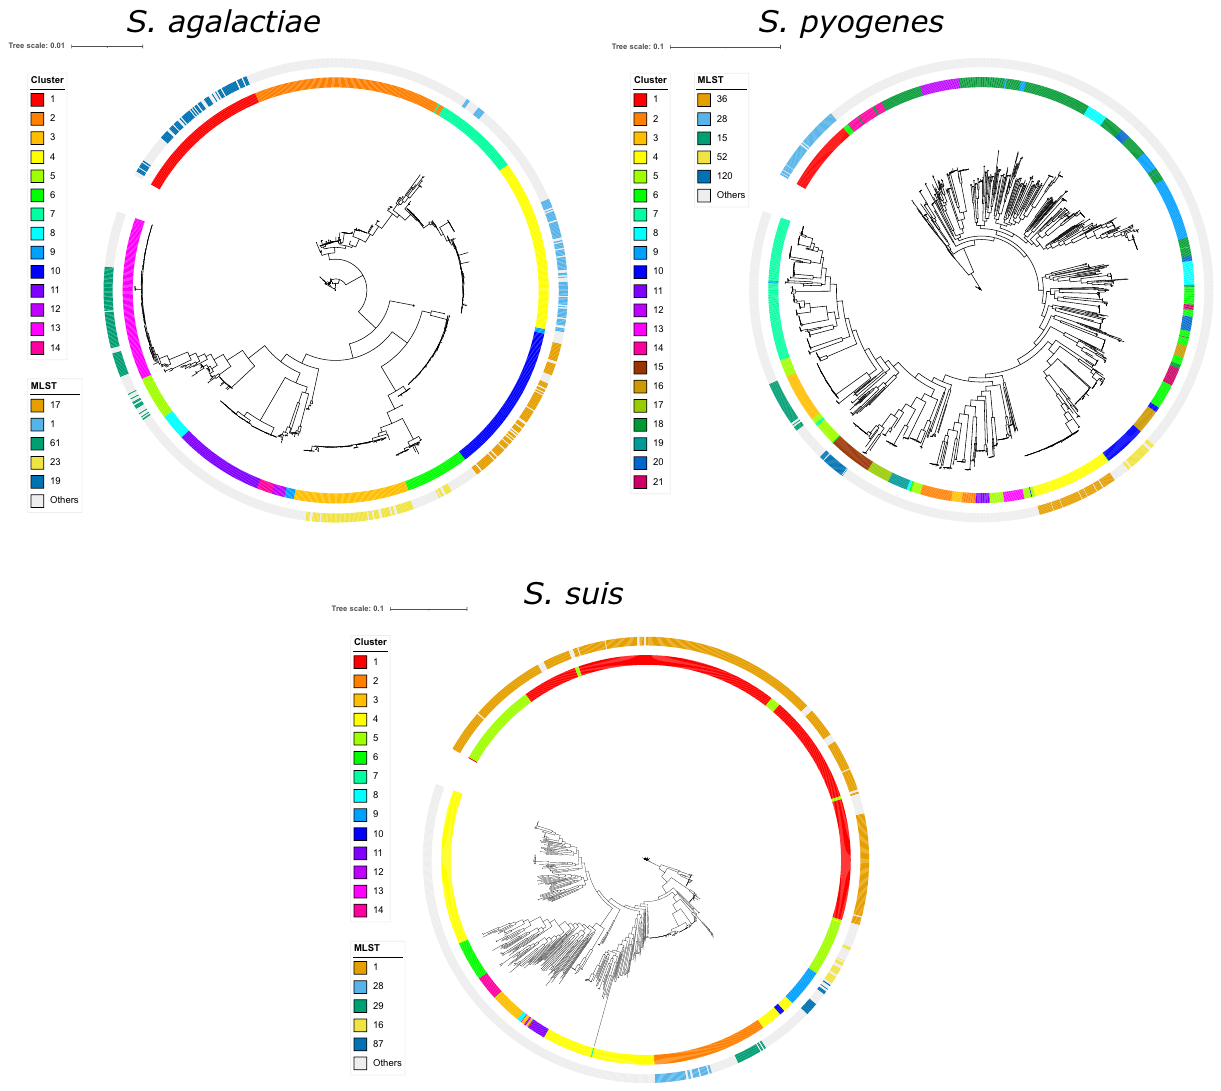
Figure 2. Midpoint-rooted maximum likelihood trees of each Streptococcus species. Scale bar represents nucleotide substitutions per site. BAPS clusters and sequence types (STs) are shown on outer rings. For visual clarity, only the most common STs are highlighted with color. Detailed multilocus ST results are listed in Supplementary Table Sequence clusters are groups of related strains with similar or closely related genotypes 29 . Multilocus sequence typing (MLST) revealed a total of 96, 435 and 211 previously known sequence types (STs) in S. agalactiae, S. pyogenes and S. suis , respectively (Fig. 2; Supplementary Table S1). The most common STs in S. agalactiae were ST 17 (96 genomes), ST 1 (93 genomes), ST 61 (91 genomes), ST 23 (82 genomes) and ST 19 (67 genomes). The most common STs in S. pyogenes were ST 36 (100 genomes), ST 28 (96 genomes), ST 15 (64 genomes), ST 52 (38 genomes) and ST 120 (36 genomes). The most common STs in S. suis were ST 1 (523 genomes), ST 28 (45 genomes), ST 29 (26 genomes), ST 16 (20 genomes) and ST 87 (17 genomes). Quantification of homologous recombination in species pan‑genomes. For each species, we sought to estimate six evolutionary and recombination parameters using the correlation profiles of synonymous substitutions for pairs of homologous sequences in the core genome alignment. We used the program mcorr to estimate these parameters 30 . The three species varied in terms of the six parameters (Table 1, Supplementary Table S3). The diversity (d), which is generated from both recombination and the accumulation of mutations of the clonal lineage 30 , was highest in S. suis (0.0417) compared to S. agalactiae (0.0072) and S. pyogenes (0.0096). The mean number of mutations per locus since divergence of a pair of homologous sites (or mutational diver- gence [θ]) 30 is highest in S. suis (0.151) compared to S. agalactiae (0.0165) and S. pyogenes (0.0560). Recom- binational divergence (ϕ) was highest in S. agalactiae (0.1905) compared to that of S. pyogenes (0.0575) and S. suis (0.865). We next calculated the ratio ϕ/θ, which gives the relative rate of recombination to mutation 30 .